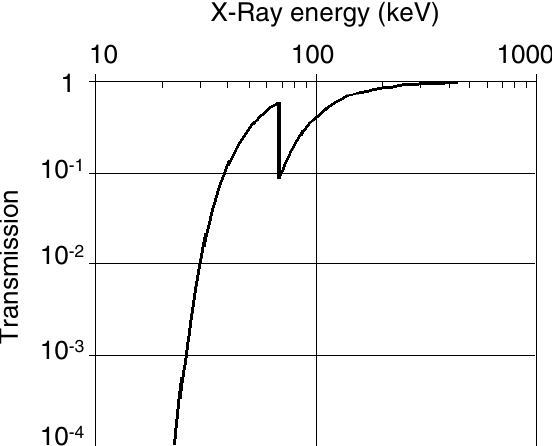
FIG. 8. Transmission probability through a 0.125 mm thick Ta foil.